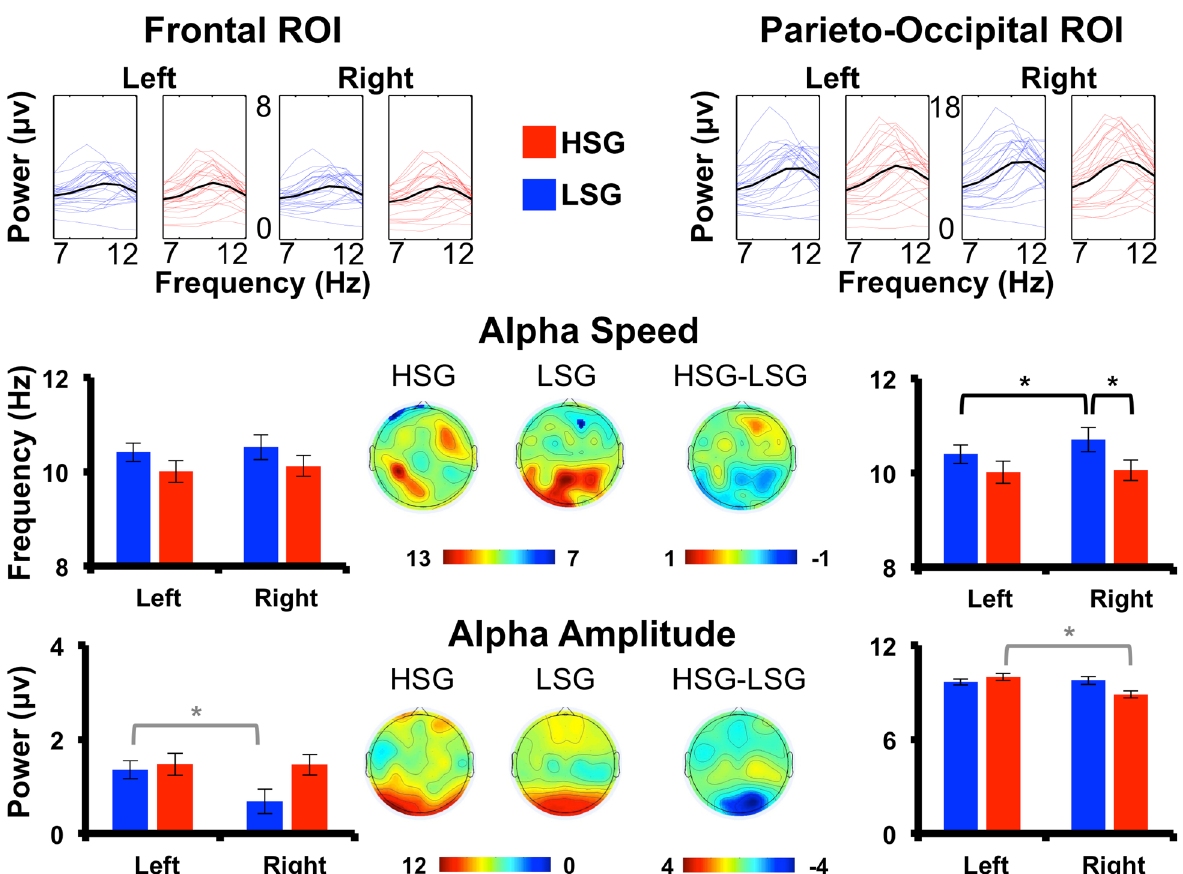
Figure 1. Individual Alpha Frequency (IAF) and Alpha Amplitude. First row: power spectra in the alpha frequency range (7–13 Hz) for left and right frontal and parieto-occipital regions of interest (ROI) divided for high schizotypy group (HSG) in red and low schizotypy group (LSG) in blue. Thin lines indicate single subject spectrum and black lines reflect group means. IAF. Observed alpha frequency peak in Hertz (Hz) for the two groups and for ROIs in both hemispheres (Left vs. Right). Topographies show scalp distribution of alpha frequency peak for the two groups and for the difference between groups. Alpha Amplitude. Observed maximum alpha amplitude in power (10*log10(μv)2) for the two groups and for ROIs in both hemispheres. Topographies show scalp distribution of alpha amplitude for the two groups and for the difference between groups. Corrected significant differences are marked with black asterisks. Uncorrected differences are marked with light-grey asterisks. Error bars represents Standard error of the mean. μv (microvolt); Hz